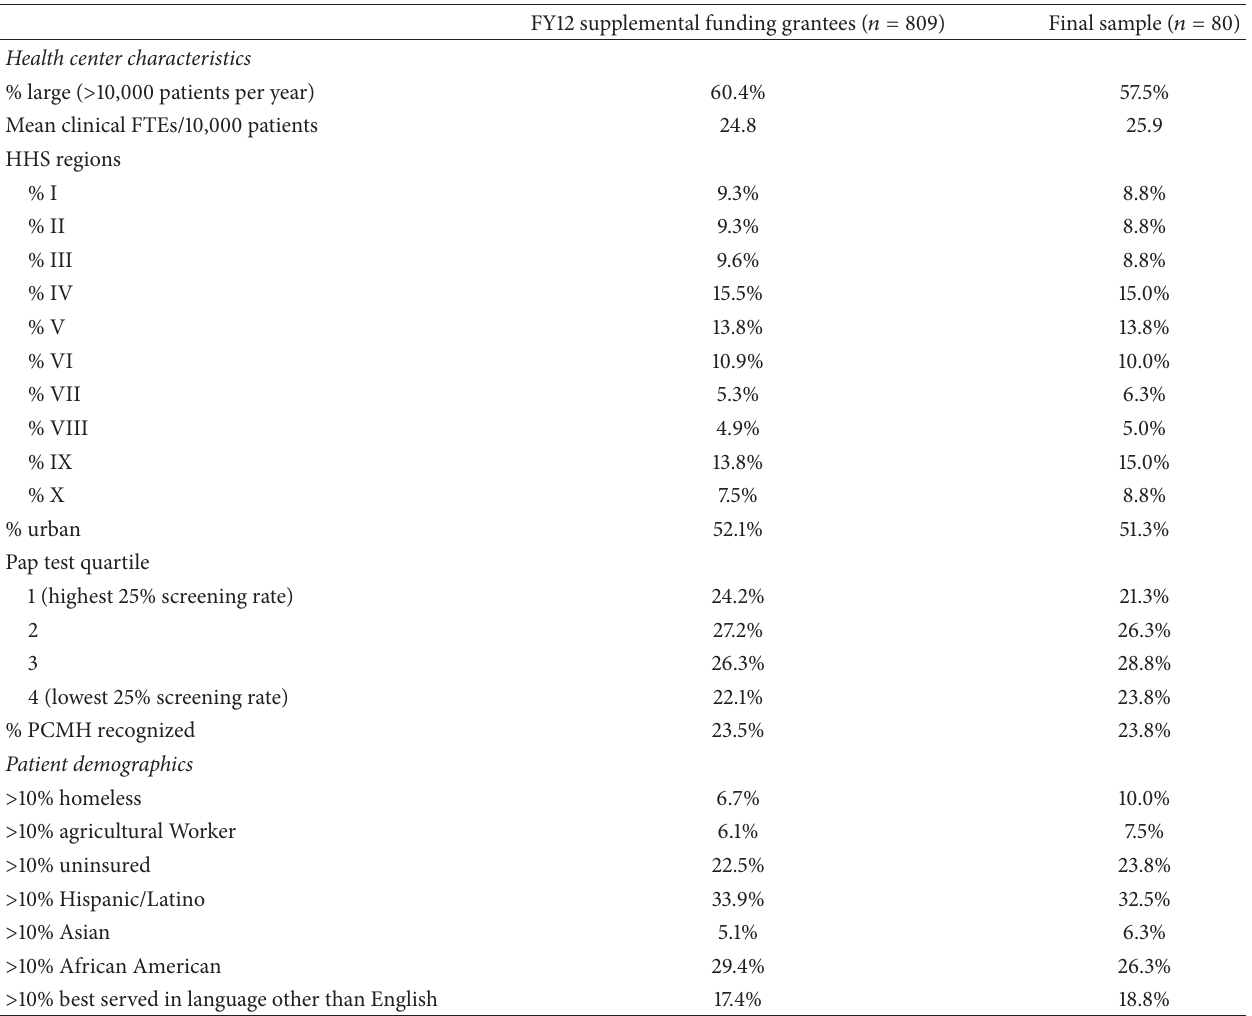
Table 1: Comparison of all grantees and sample grantees by general health center characteristics and patient